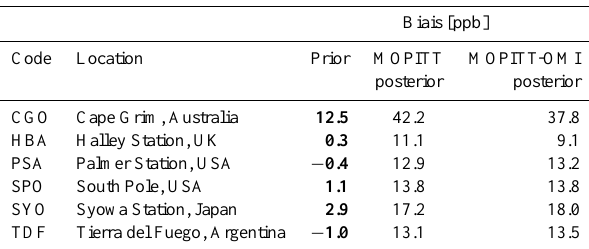
Table 4. Same as Table 3, but for the 6 stations chosen in the high- latitudes of the Southern